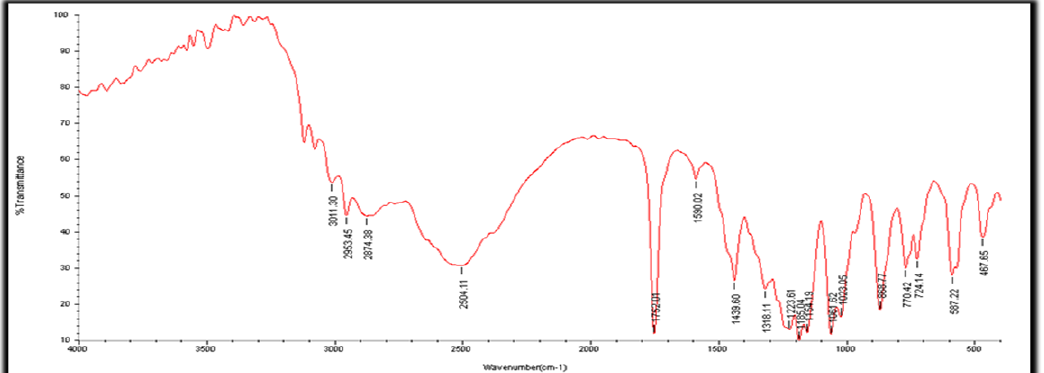
Figure 5. FTIR spectrum of pure